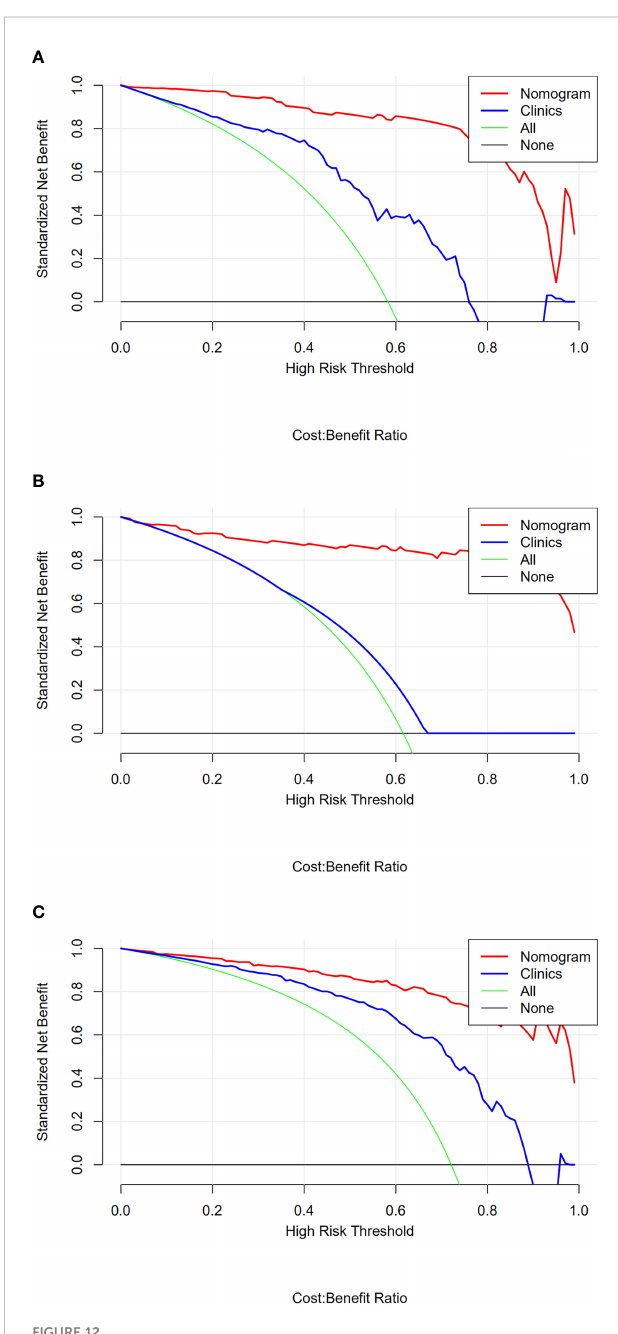
FIGURE 12 (A-C) are the decision curves of nomogram models 1, 2, and 4 for the corresponding lymph node classi fi cation in the test group, respectively. The red line in the fi gure represents the diagnostic nomogram model built from the imaging features, and the blue line represents the diagnostic nomogram model built from the clinical features. The green line represents the hypothesis that all patients had lymph node metastasis; the black lines running across the bottom are assuming that none of the patients had lymph node metastasis. The potential clinical bene fi ts of the radiomics-based models are consistently higher than those of the other three